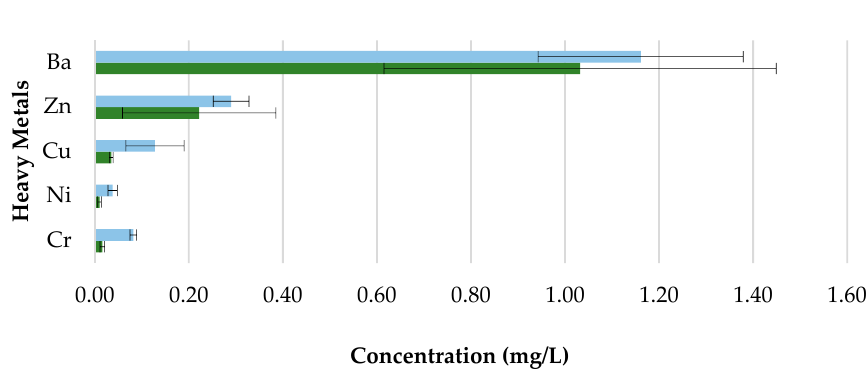
Figure 21. Heavy metal concentration of 2% CB content bricks before and after firing.